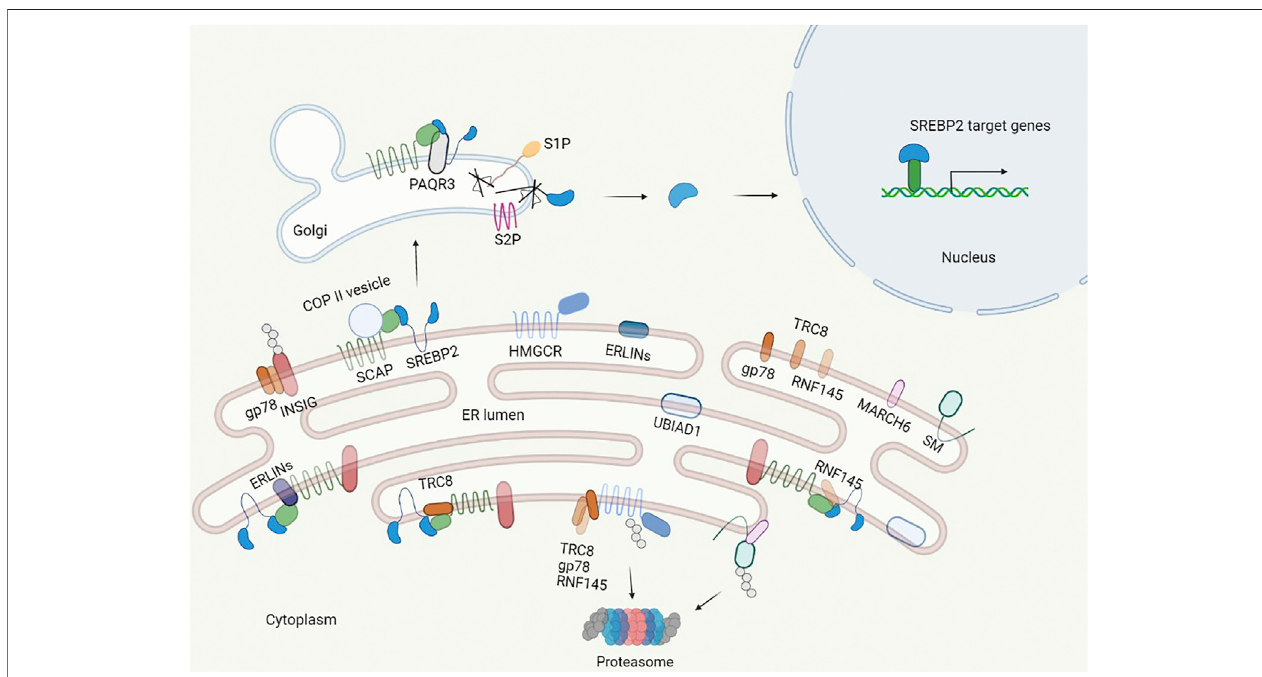
FIGURE2| Regulationofcholesterolsynthesis.Thecentral transcription factor ofcholesterol synthesisincellsisSREBP2, whichisregulatedinmultiplelayersand controlsthesynthesisofkeyenzymesincholesterolsynthesis.SREBP2bindstoSCAPintheER.Whenthecholesterollevelislessthan5%oftheER,SCAPbindstothe COPIIproteinandescortsSREBP2fromtheERtotheGolgiandanchors via adipoQreceptor3(PAQR3)intheGolgi,wheresite1andsite2proteases(S1P,S2P)cleave the luminal loop of SREBP2 to release the N-terminal domain that enters the nucleus. In the nucleus, SREBP2 activates multiple cholesterol synthesis genes by bindingtotheSRE.Additionally,theINSIGproteinsdissociatefromSCAP,andHMGCRandSMarelessboundandubiquitylatedbyE3ubiquitinligaseanddegradedby the proteasome. Whenthe cholesterol levelis more than 5%oftheER, the INSIGs arerecruitedbySCAP toform theSCAP – SREBP2 – INSIG complex, and the complex holds in the ER further by ERLINs and TRC8. Additionally, cholesterol induces the E3 ligase complex to ubiquitylate HMGCR and SM.